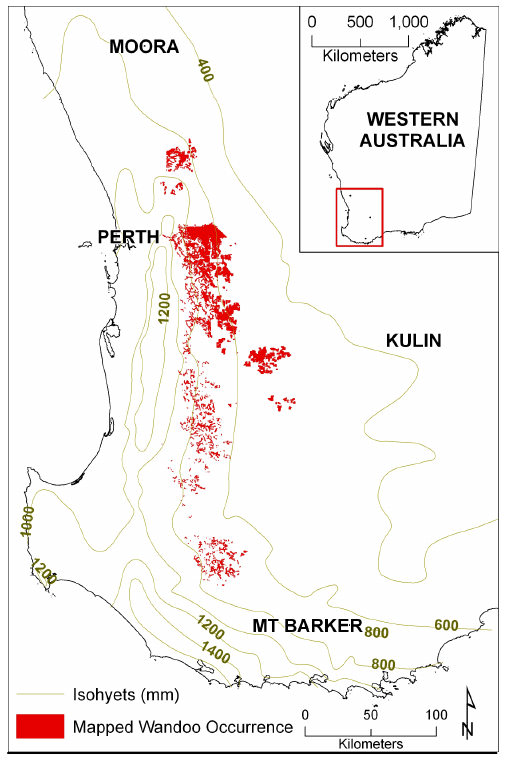
1000mm (figure 1) (Caphill 1984). The tree can grow up to 30 metres high and achieve a girth of three metres, this reduces in lower rainfall zones (White and Manning, 2005).